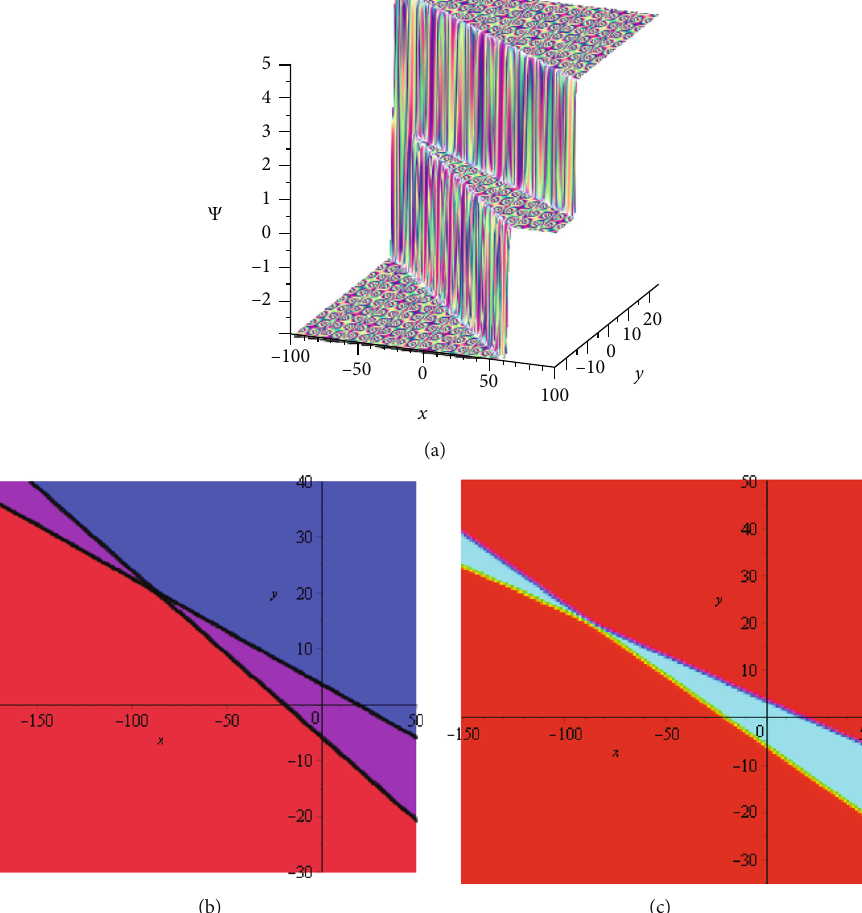
= : 5, a = 1 : 5, a = 2, a = 1, Ω = 1 : 9, Ω = : 2, Ω = 2, δ = 1, δ = 1 : 3, δ 1 2 3 4 2 6 7 1 2 3